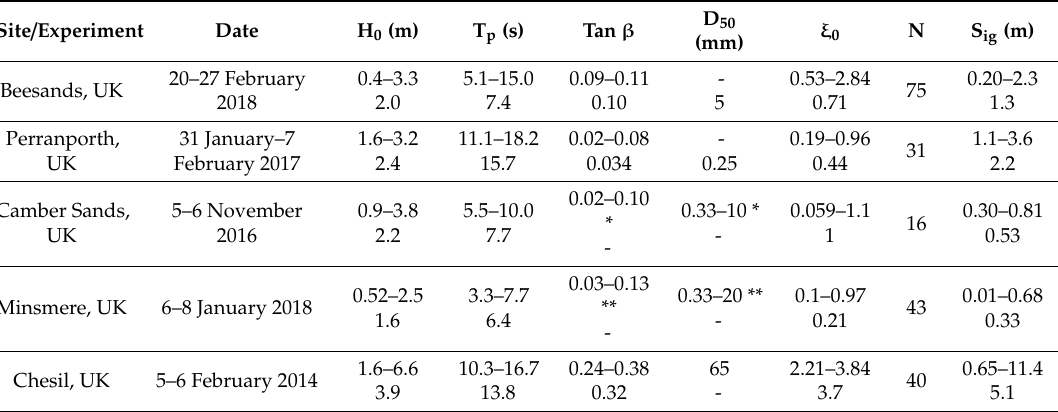
Table 3. Summary (range and mean) of environmental parameters sampled during the presented research. Subscript 0 indicates parameters calculated using deep water values linearly deshoaled to 80 m depth. N = number of 20-min data runs; UK = United